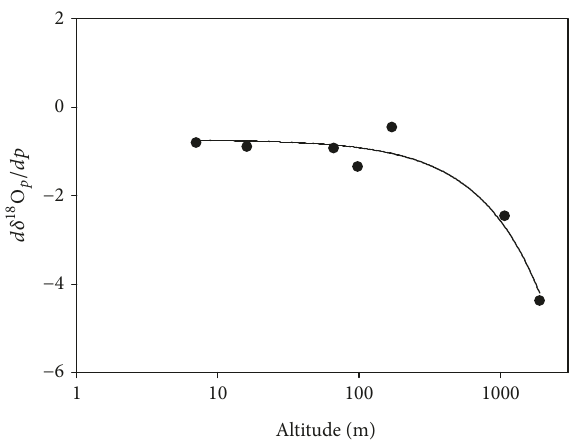
Figure 2: Correlations of 𝑑𝛿 18 O 𝑝 / 𝑑𝑃 ( 𝑟 𝛿